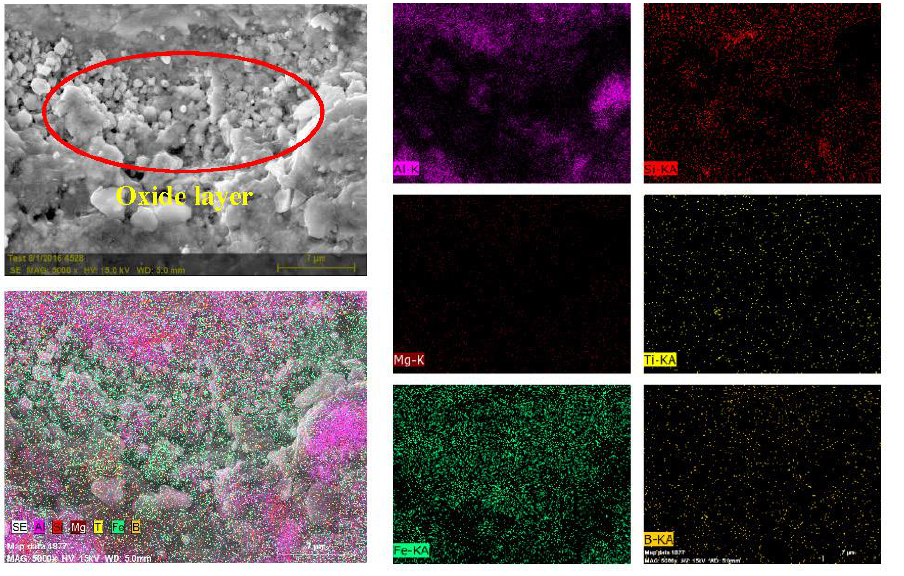
Fig. 14. EDS mapping of Al-Si-Mg/TiB 2 composites at 9 h ageing time, 2.5 m/s sliding speed and 24.52